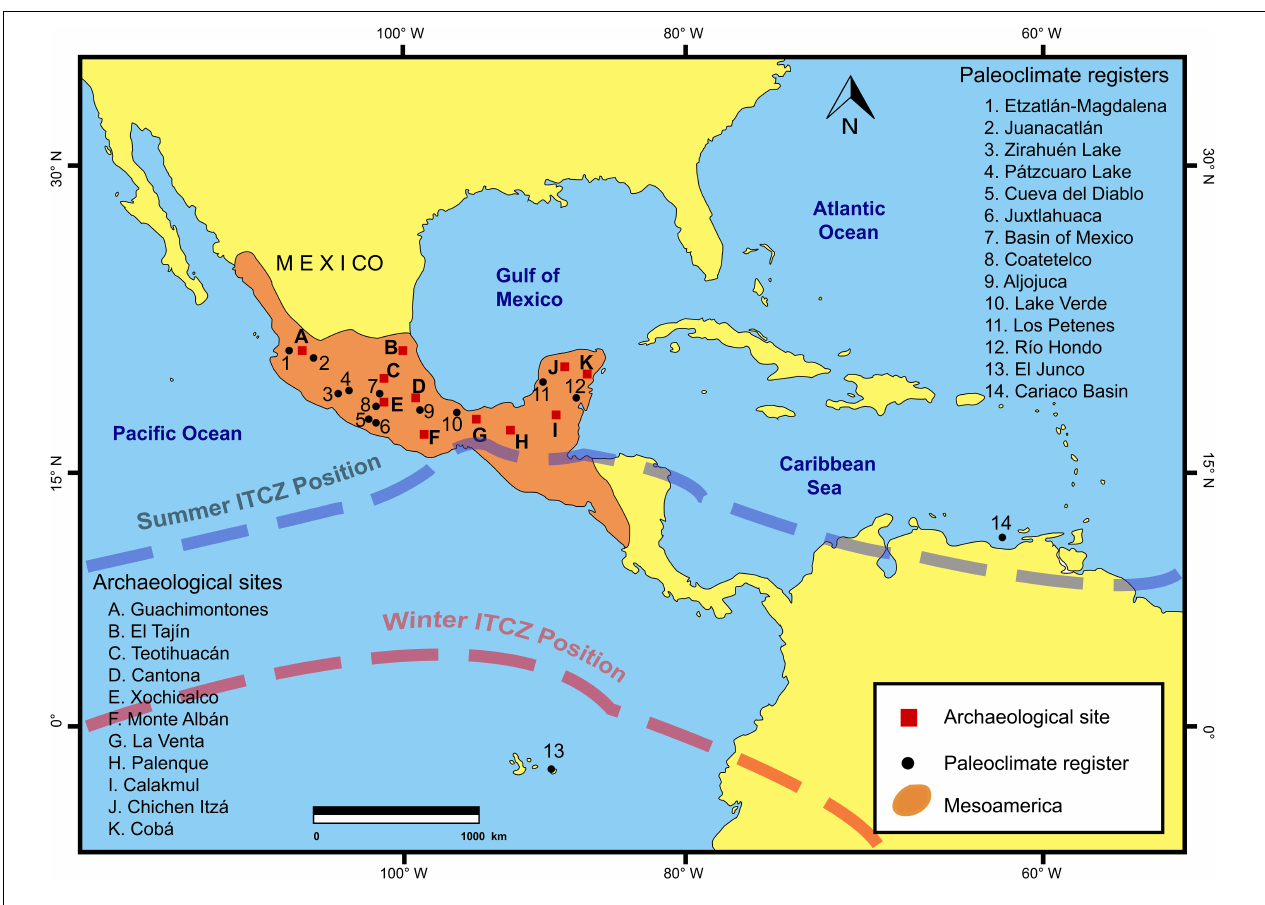
FIGURE 1 | Location map of Mesoamerica, archeological sites, and locations of different paleoclimate registers discussed in this paper. Lake Coatetelco in southwest Mexico is situated next to the archeological site of Coatetelco and at 8 km southwest from the archeological site of Xochicalco. It is present at southern margin of the Trans-Mexican Volcanic Belt (TMVB) and about 85 km from Mexico City